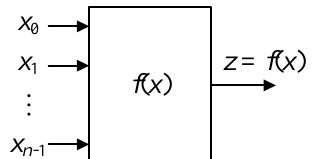
Figure 12. A nonlinear function f with n input sequences.